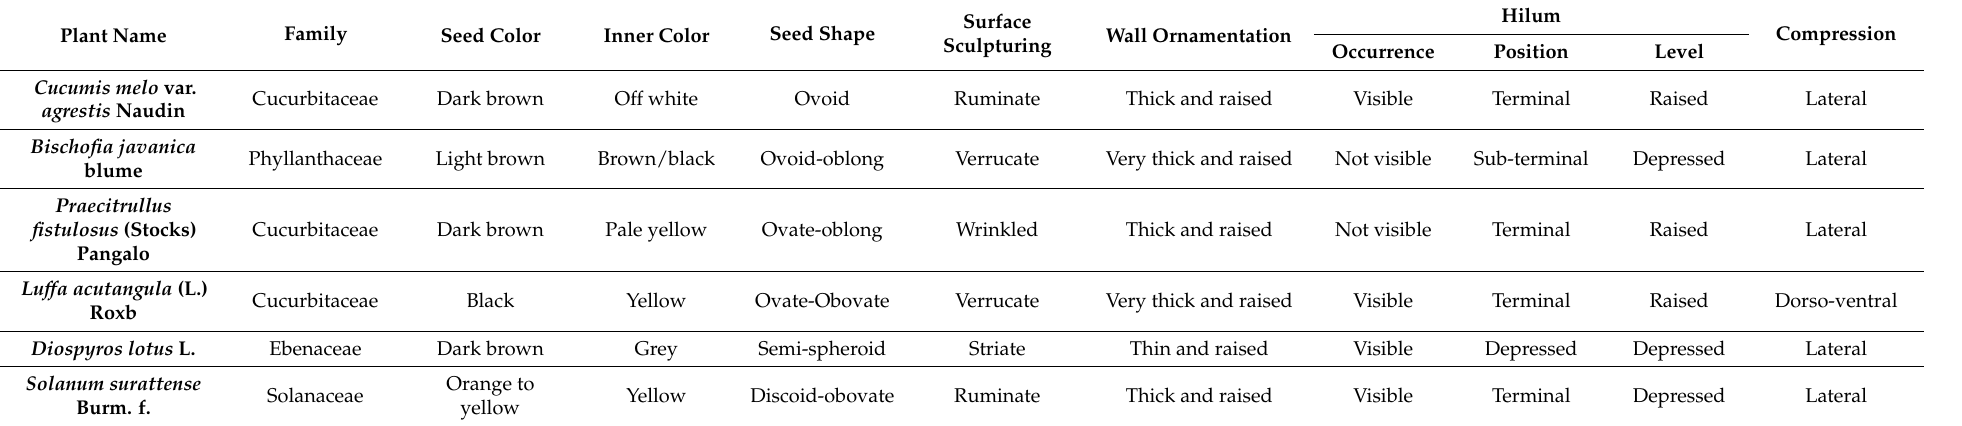
Table 1. Qualitative characteristics of seed-bearing energy crops.